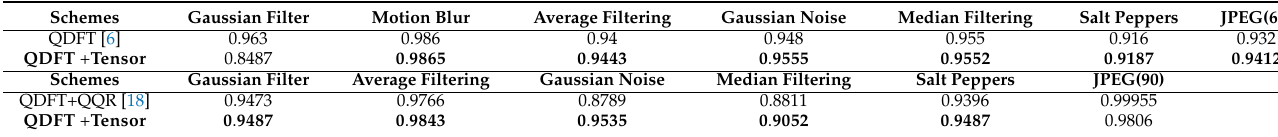
Table 4. NC under the image processing attacks.